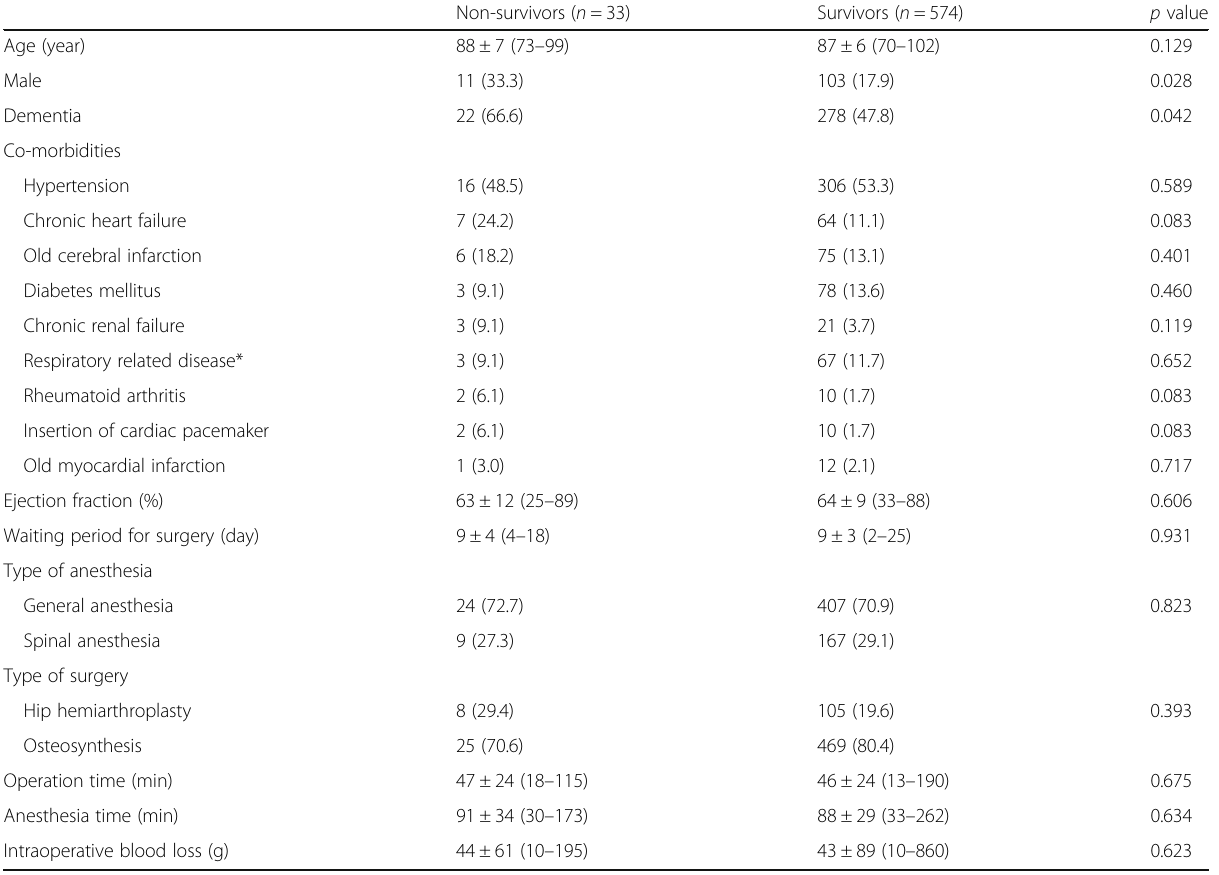
Table 1 Comparison of clinical characteristics between the non-survivors and